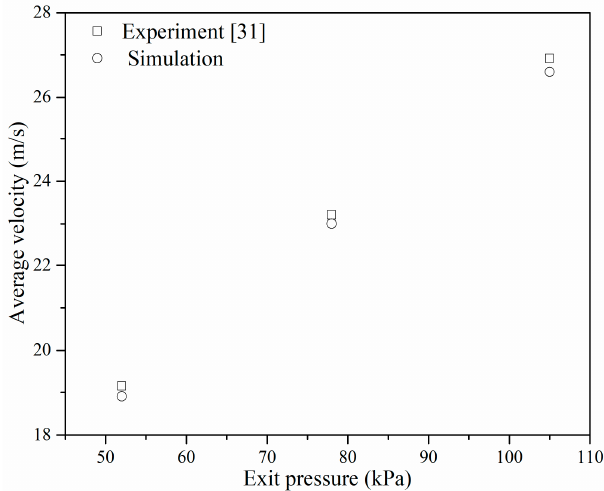
Figure 3. Comparison with experimental results.